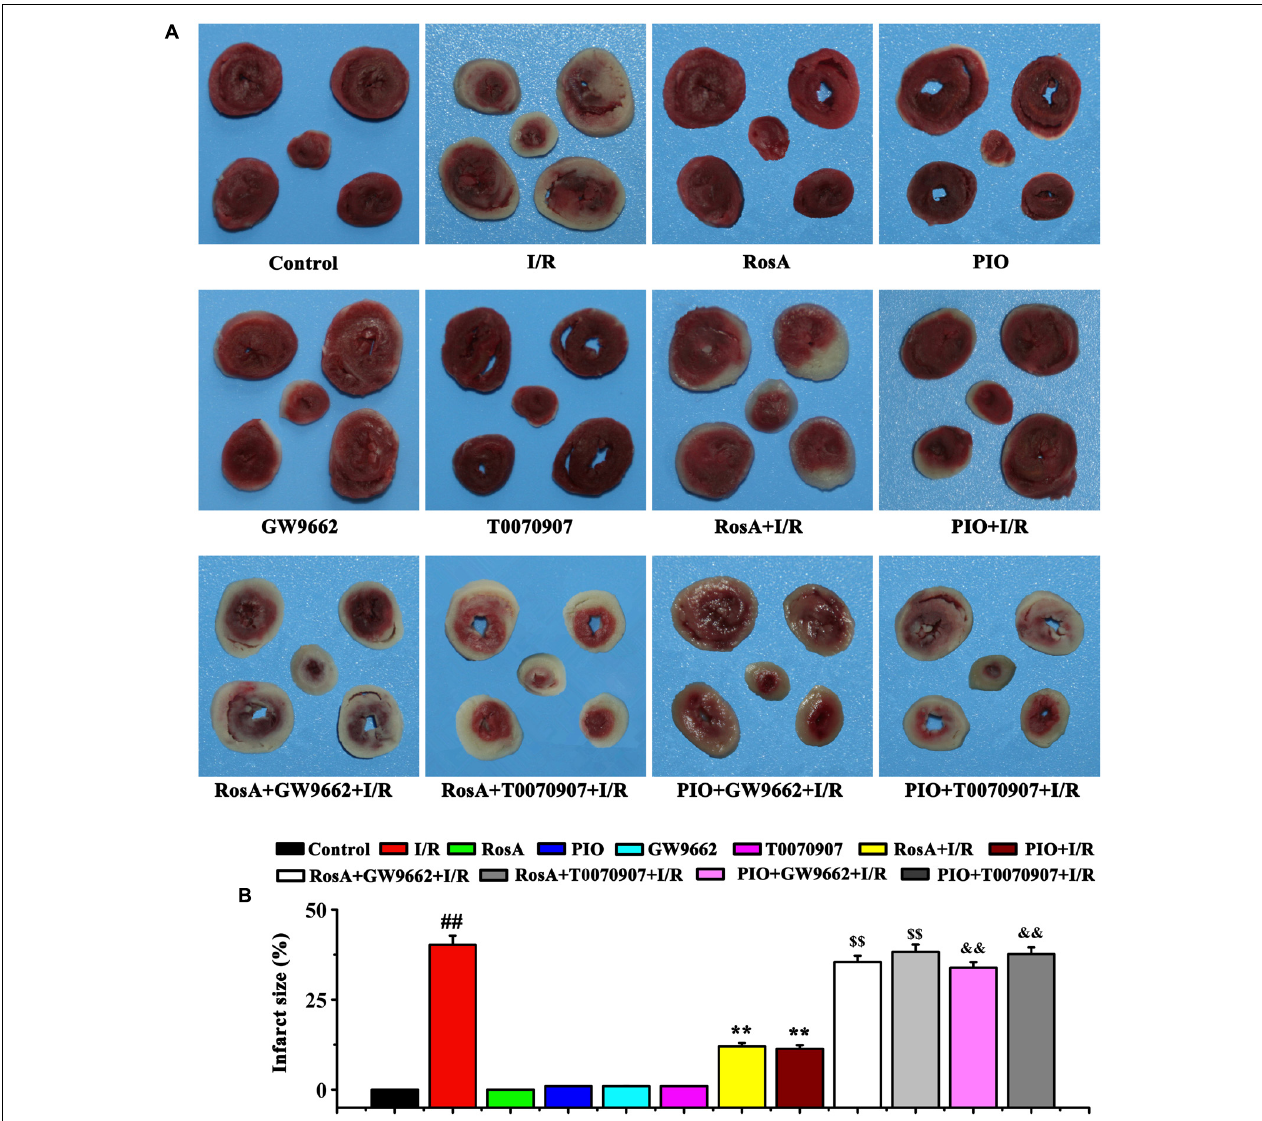
FIGURE 2 | The effect of RosA on the size of I/R-induced infarcts. (A) The infarct size was measured by TTC staining. (B) Statistic analysis of the size of I/R-induced infarcts. ## P < 0.01 compared to the control group; ∗∗ P < 0.01 compared to the I/R group. Compared with the I/R+RosA group, $ P < 0.05, $$ P < 0.01. Compared with the I/R+PIO group, & P < 0.05, && P <